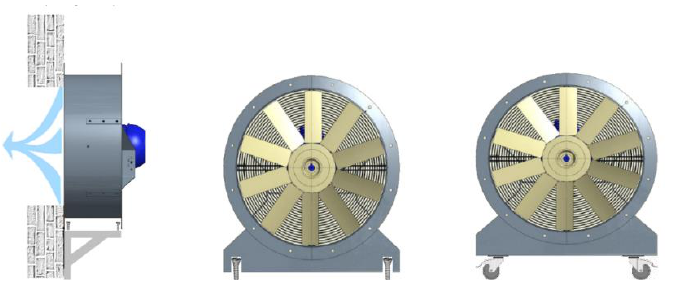
Figure 4. Example of a large fan.